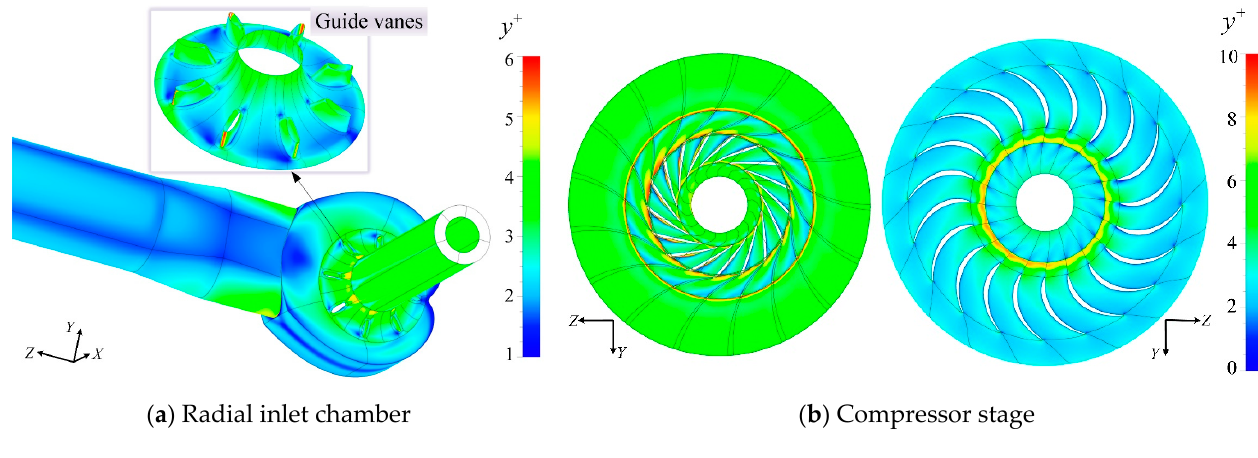
Figure 5. y + distributions of the computational grids .